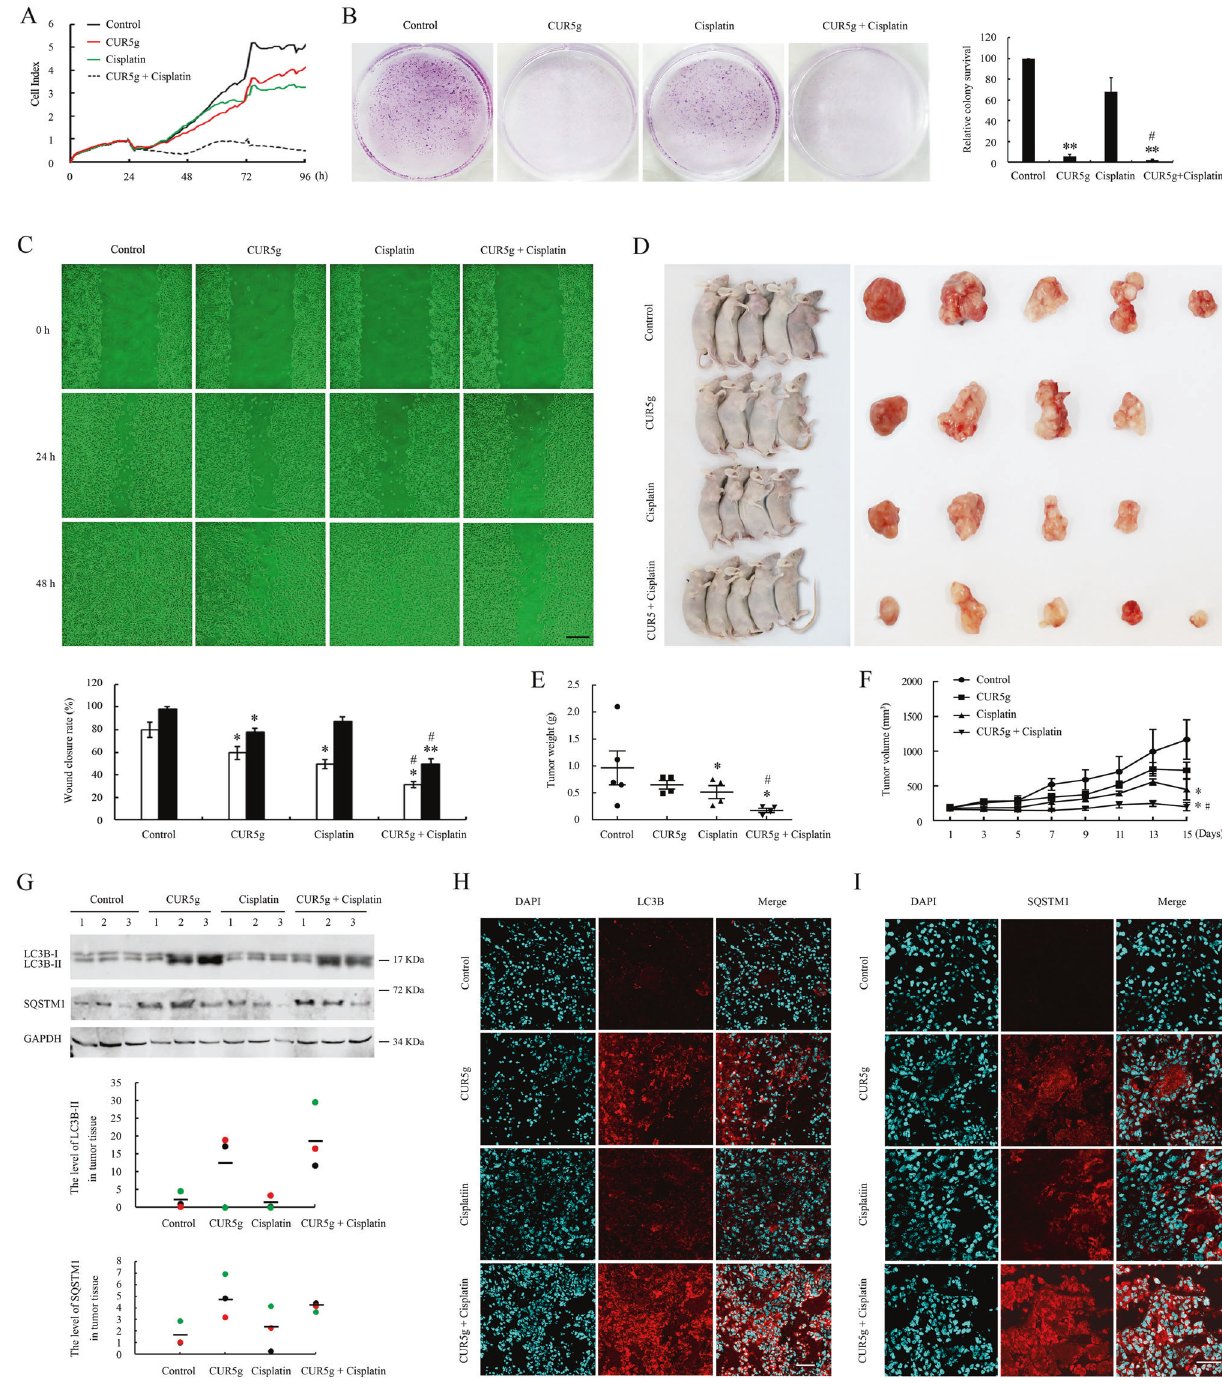
Fig. 7 CUR5g exhibits synergistic anticancer effects with cisplatin and inhibits autophagic fl ux in vivo. A Cell number was monitored over 96 h in a real-time manner using an xCELLigence RTCA S16 System. DMSO, CUR5g (10 μ M), cisplatin (30 μ M), or CUR5g (10 μ M) plus cisplatin (30 μ M) was added after the cells were seeded into the plates for 24 h. B Representative images of colony formation assay of A549 cells treated with DMSO, CUR5g (10 μ M), cisplatin (30 μ M), or CUR5g (10 μ M) plus cisplatin (30 μ M) for 12 days. Histogram shows the relative colony survival. ( n = 3; ** p < 0.01 vs. Control, # p < 0.05 vs. cisplatin). C The effect of DMSO, CUR5g (10 μ M), cisplatin (30 μ M), or CUR5g (10 μ M) plus cisplatin (30 μ M) on the migratory potential of A549 cells was analyzed through a wound-healing assay. Microscopy photographs were taken after treatment for 0, 24, or 48 h, respectively. Scale bar = 100 μ m. Histogram showed the wound closure rate. ( n = 3; * p < 0.05; ** p < 0.01 vs. control, # p < 0.05 vs. cisplatin). D Images show all the animals and tumors in the experiments. E Tumor weight was measured on the day of sacri fi ce. (Each group mice n = 4 – 5; * p < 0.05 vs. control, # p < 0.05 vs. cisplatin). F Tumor volume were recorded every 2 days for up to 15 days. (Each group mice n = 4 – 5; * p < 0.05 vs. control, # p < 0.05 vs. cisplatin). G Western blot analysis of LC3B-II and SQSTM1 in tumor tissues. 3 tumor tissues were randomly selected from each group for analysis. GAPDH was used as a loading control. Scattergram shows the densitometric analysis of LC3B-II and SQSTM1 in tumor tissues. H , I Representative fl uorescence images of LC3B ( H ) or SQSTM1 ( I ) in tumor sections. Nuclei were stained with DAPI. Scale bar = 80 μ